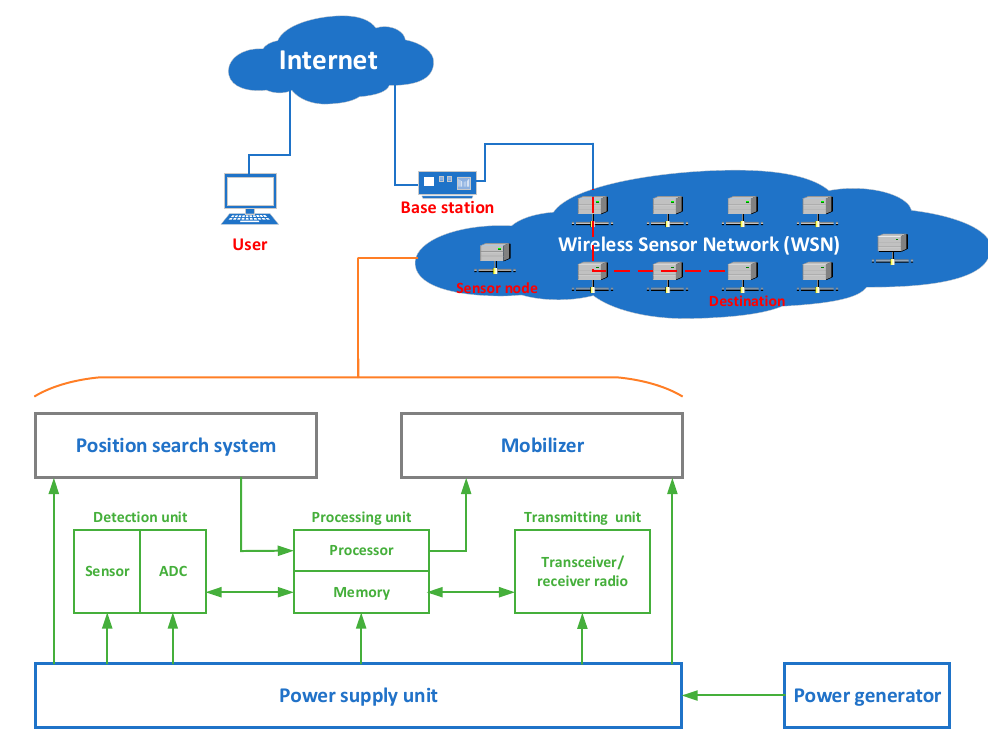
Figure 2. A schematic of a typical WSN structure along with a sensor node diagram